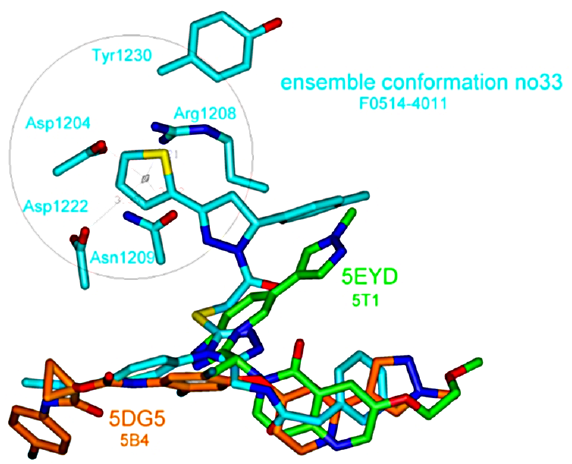
Figure 7. Comparison of the conformations between F0514-4011, the U-shape inhibitor 5T1 (AMG337), and the linear-shape 5B4 (altiratinib), as observed in their respective binding